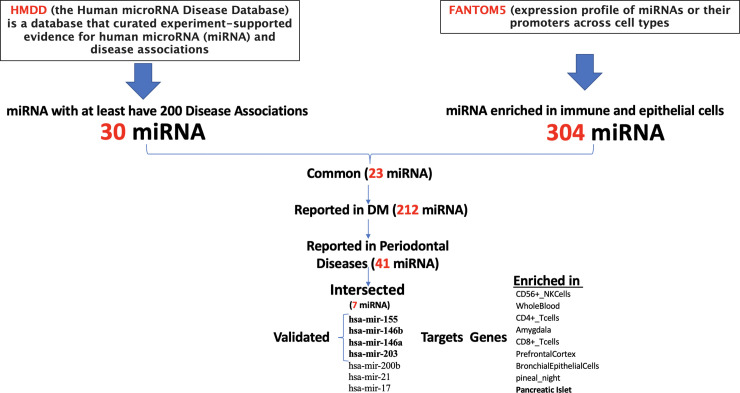
Flowchart for bioinformatics search for candidate salivary miRNA markers in periodontal diseases and diabetes mellitus.